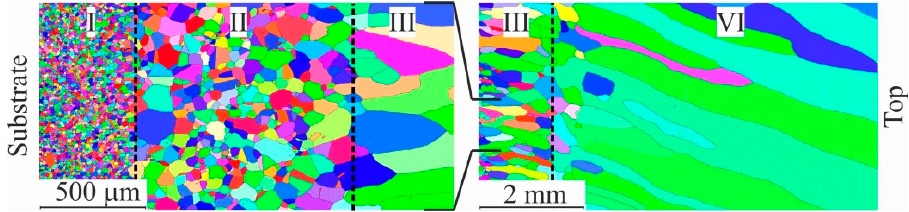
Figure 11. IPF maps in the Z direction of the C-type copper block. The following regions are